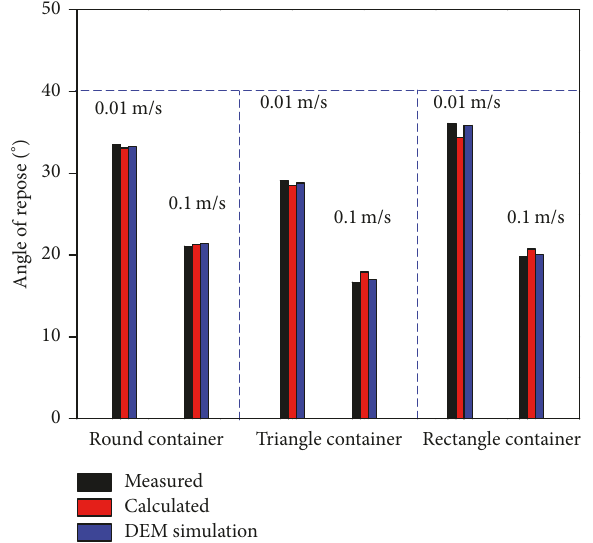
Figure 12: Comparison of measured, calculated, and DEM simula- tion on angle of